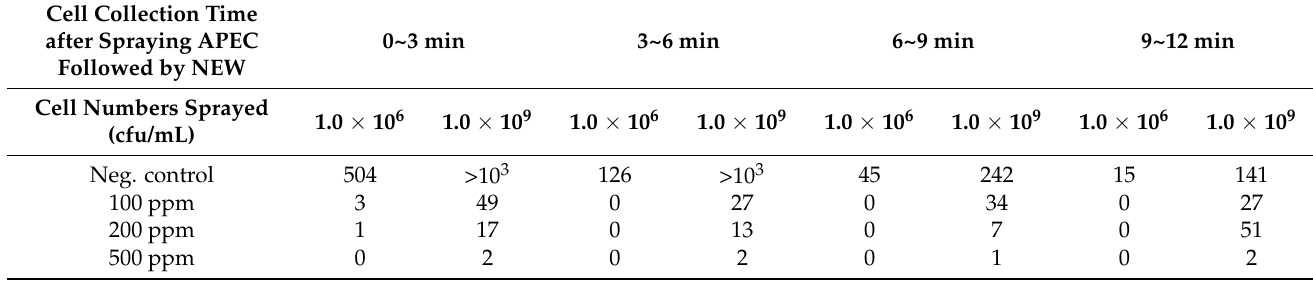
Table 1. APEC strain recovered from each group used in the study.